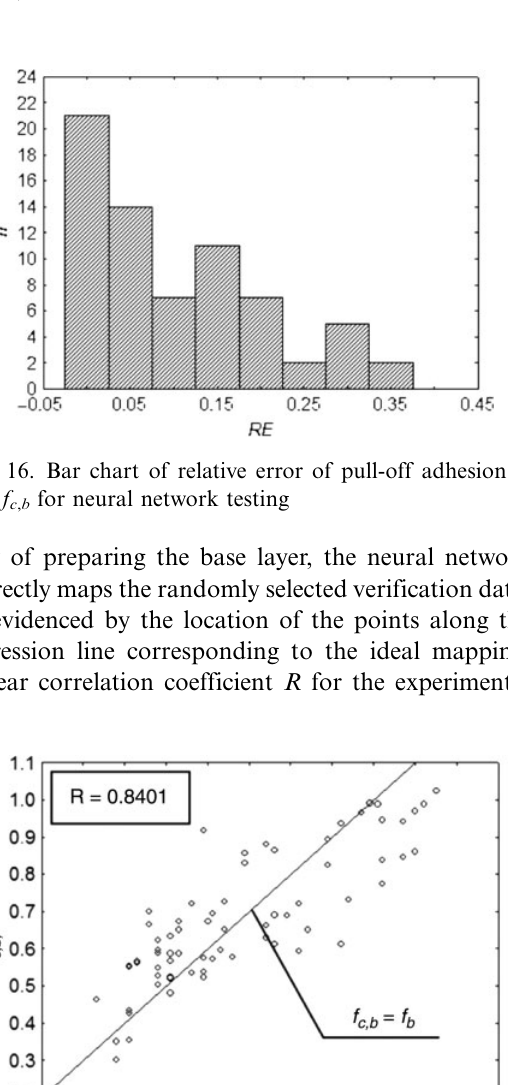
Fig. 15. Bar chart of relative error of pull-off adhesion f b and f c , b for neural network training